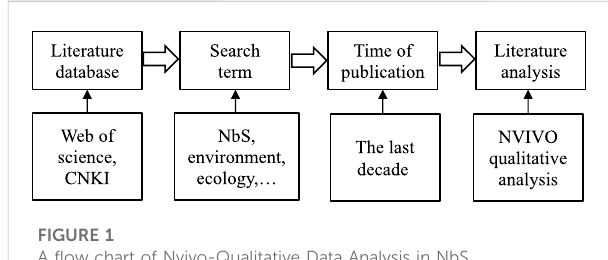
FIGURE 1 A fl ow chart of Nvivo-Qualitative Data Analysis in